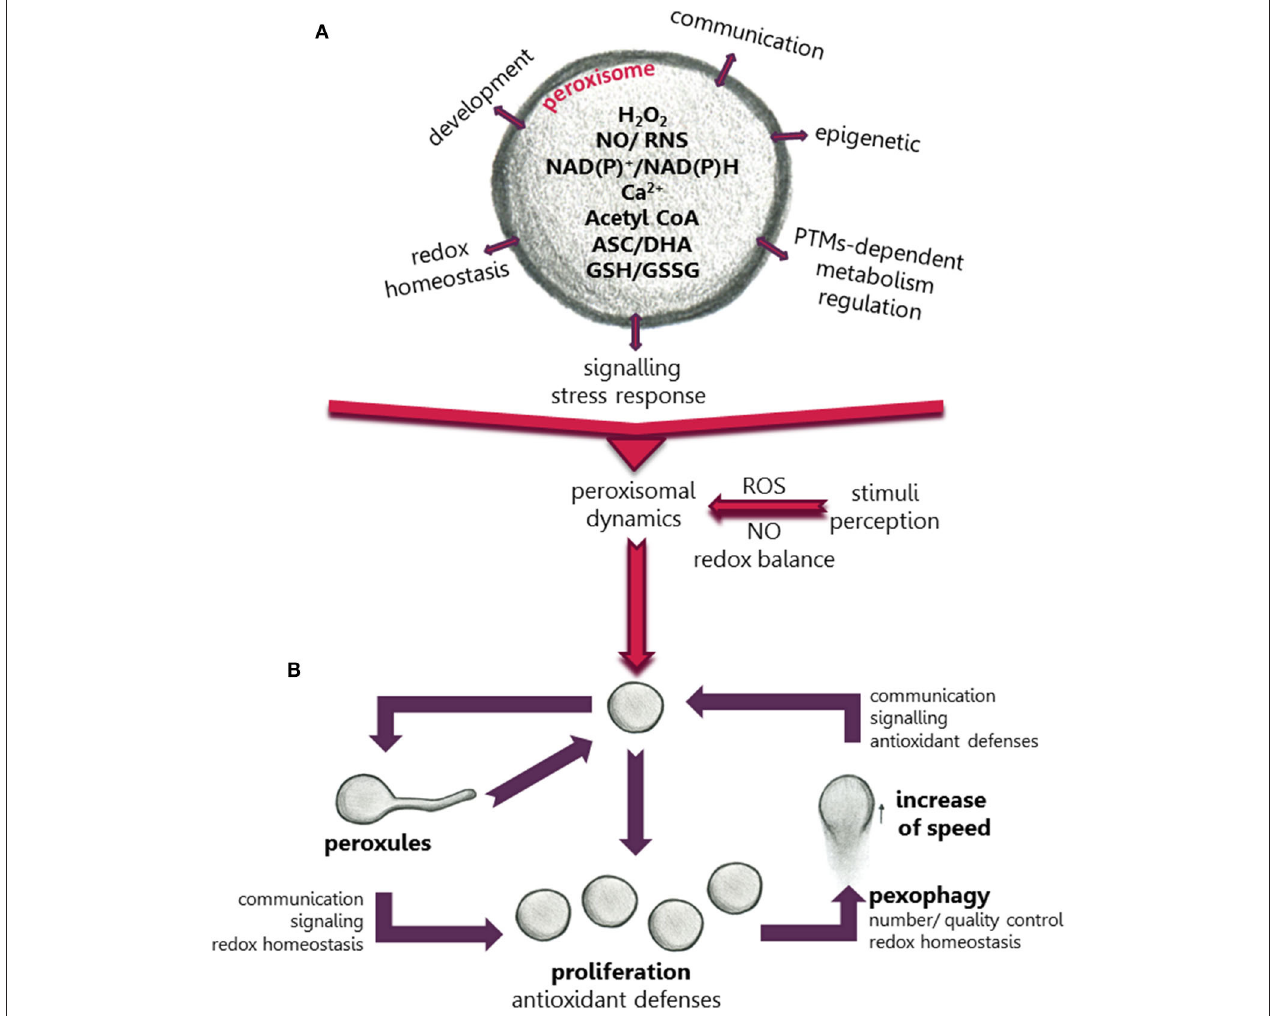
FIGURE 1 | Scheme showing the role of peroxisomes in the regulation of metabolism, development and plant cell responses to environmental changes. (A) The regulatory role is mediated by ROS, NO, Ca + 2 , redox balance, and other compounds produced in peroxisomes. (B) Changes in peroxisomal dynamics and function in response to environmental stimuli mediated by changes in cellular ROS